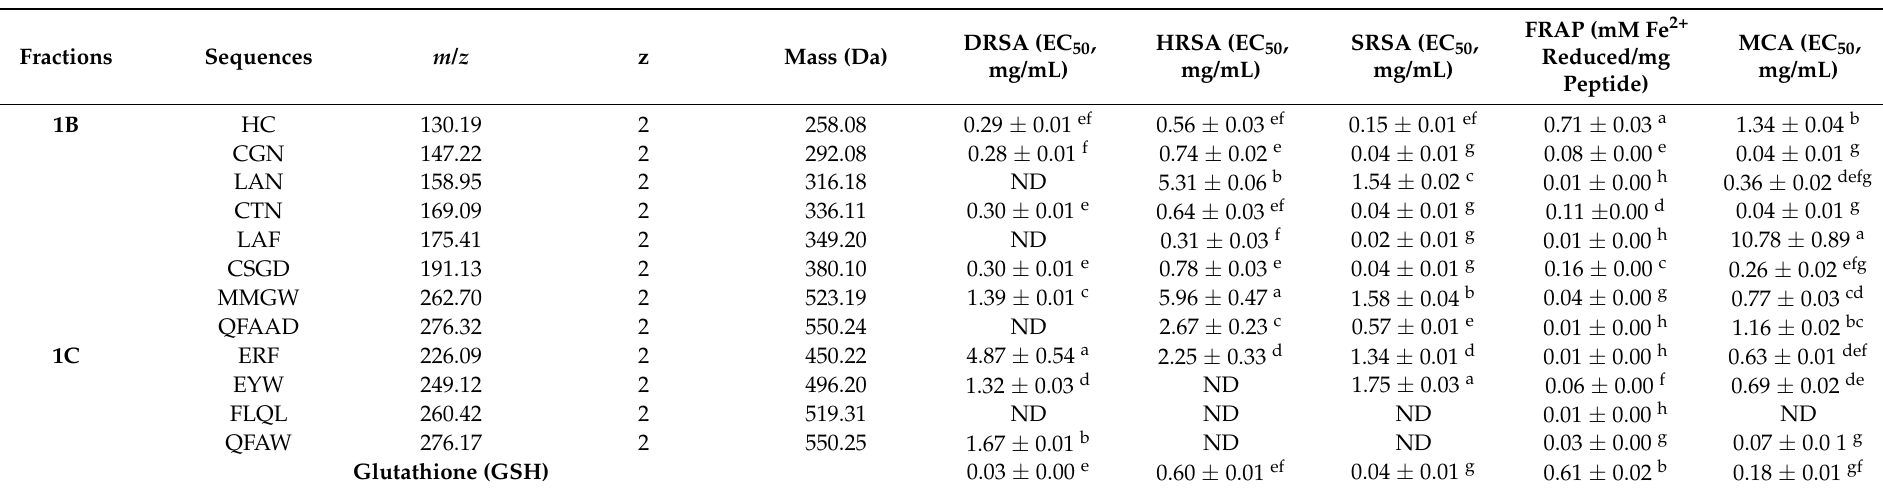
Table 1. Antioxidant activities of selected peptide sequences identified from fractions 1B and 1C